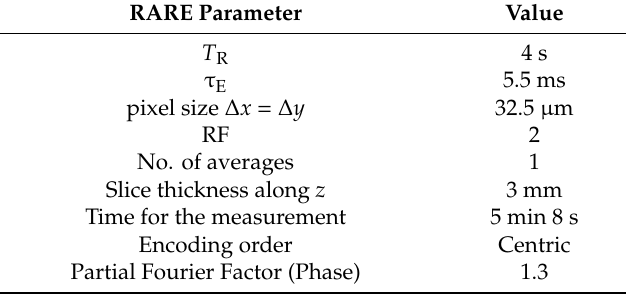
Table 2. Main RARE parameters for in-situ MR measurements of dead-end filtration of skim